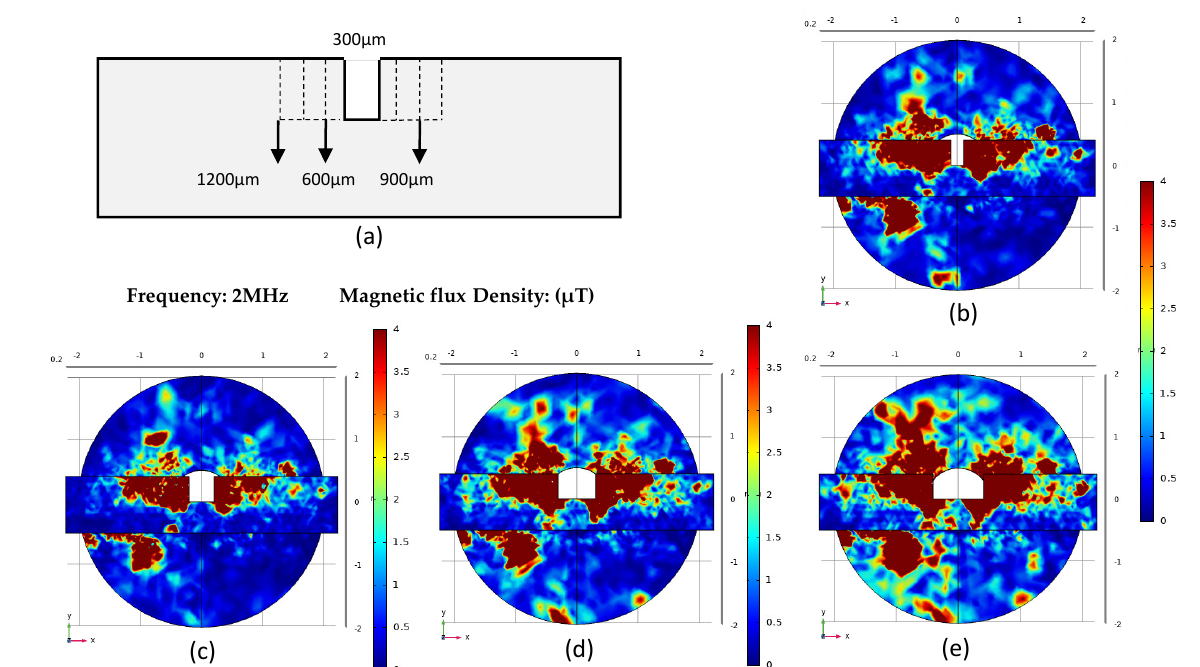
Figure 5. Comparison of simulation results of permalloy triangle notches: ( a ) Different permalloy structures; ( b – e ) Simulation results.